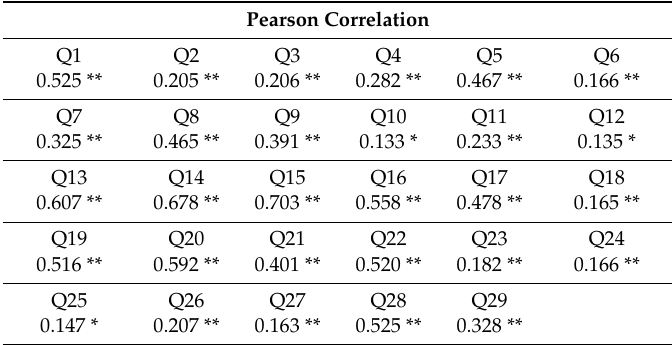
Table 2. Internal validity of the questionnaire (253